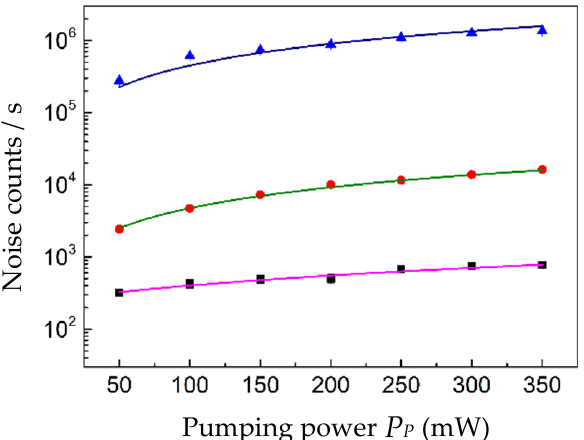
(data points in the middle). Finally, the third stage filter is also added, and the noise is further reduced as shown by the black squares (data points in the bottom). Under this condition, for P P = 350 mW the noise counting rate is decreased to N = 780/s. The noise level is related to the pumping power. We fit the noise date by using the expression [29]: N ( P P ) = α × P P + DC , where α is the linear coefficient, and DC = 2.5 × 10 2 /s is the dark count rate of SPD. The solid lines in Figure 3 are the fitted curves, which are in good agreement with the experimental data. For the fitted lines from top to bottom, the slope α is taken as 4.5 × 10 3 /mW/s, 4.5 × 10/mW/s and 1.52/mW/s, respectively. It is illustrated that the second-stage filter (cascaded etalons) reduces the noise level by two orders of magnitude, and the third-stage filter (F-P cavity) reduces the noise by another order of magnitude.